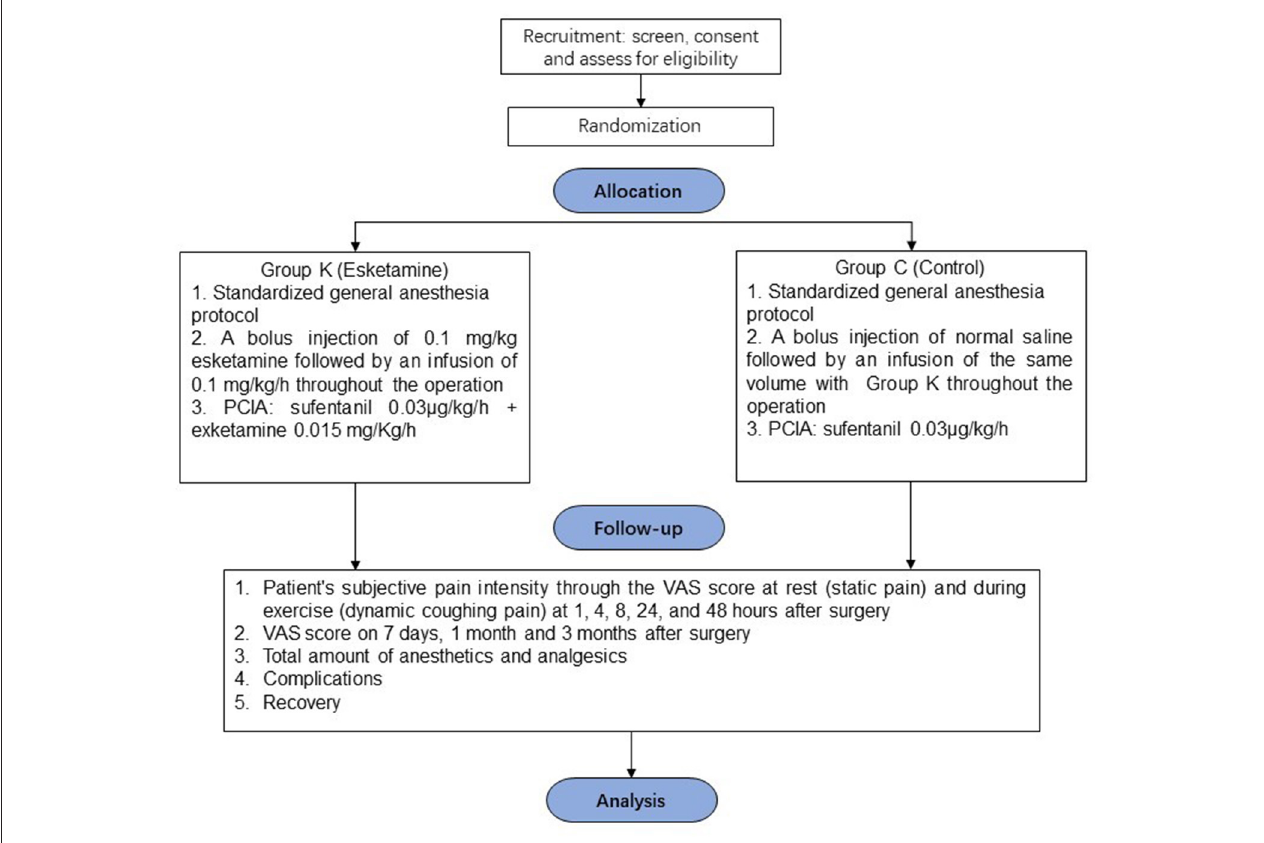
FIGURE 1 | General review of study